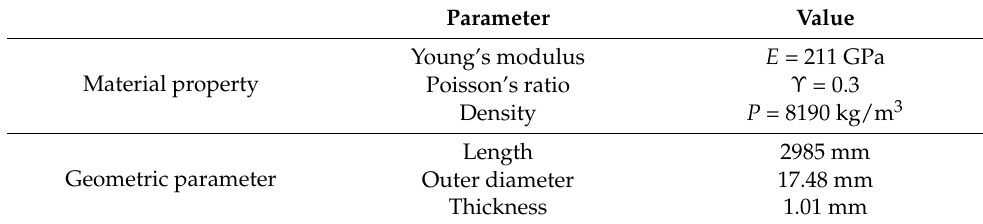
Table 1. Parameters of modeling.